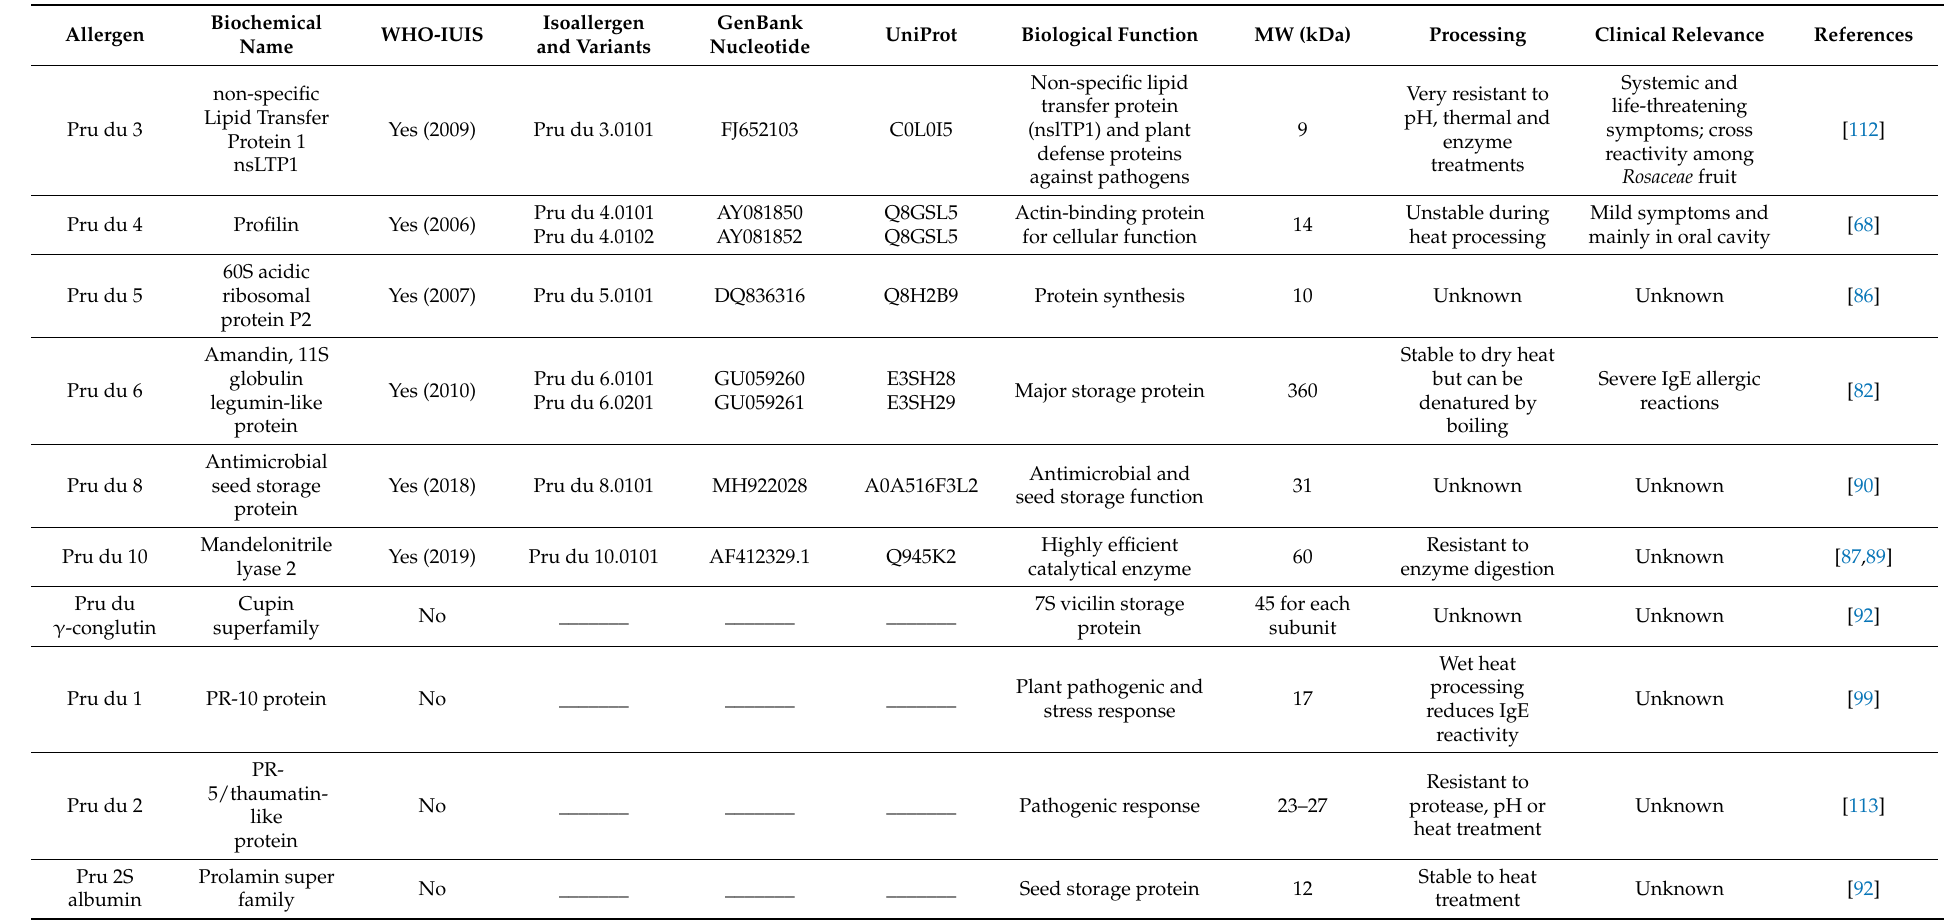
Table 2. Almond allergens and their biological function, molecular weight, food processing effects and clinical